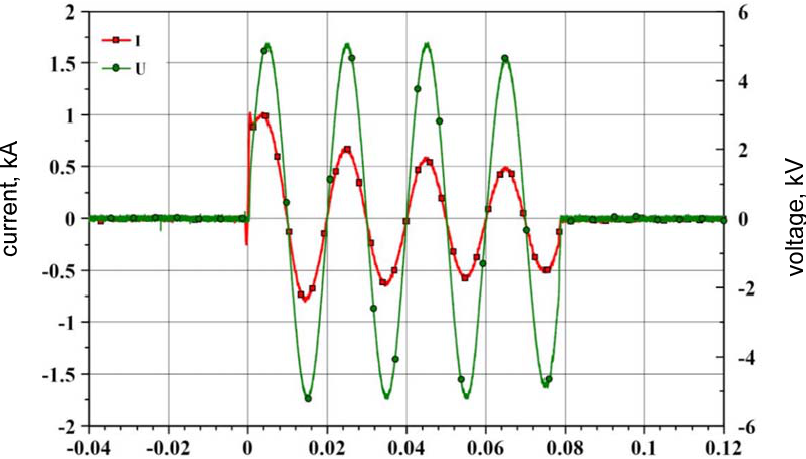
Figure 5. The course of the short-circuit current and the measured voltage at the limiter—short-circuit test No. 2. ( T 0 = 80 K). I–current, U–voltage.